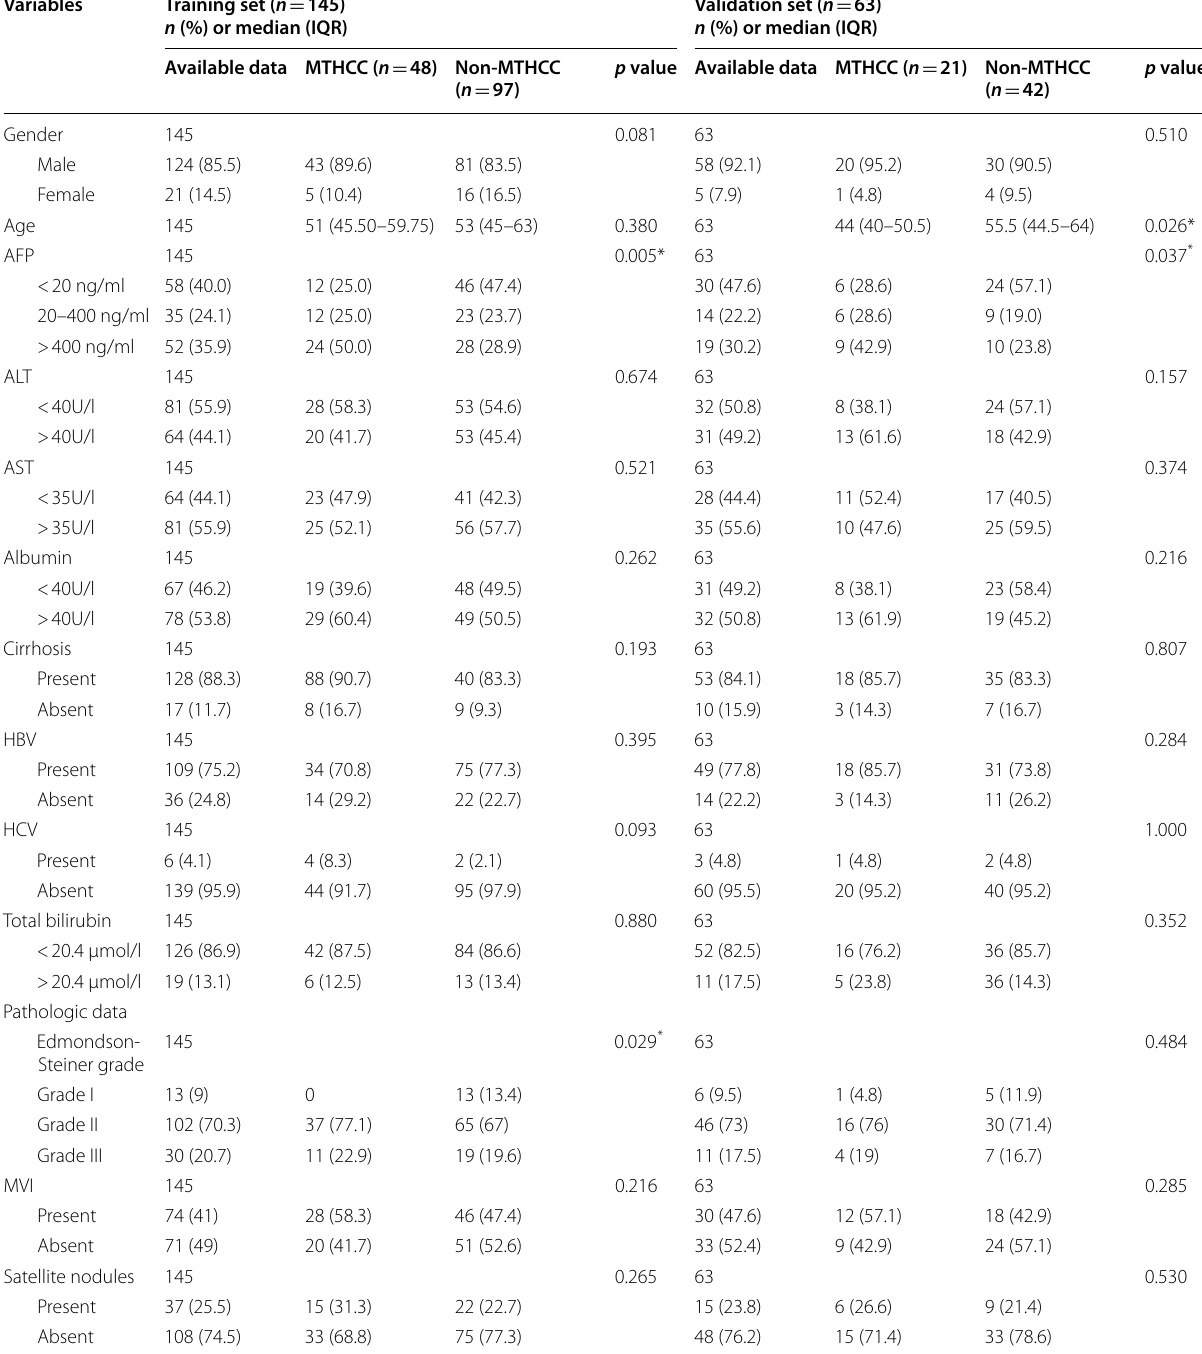
Table 2 Demographic, clinical, and pathologic characteristics of 208 patients according to MTHCC